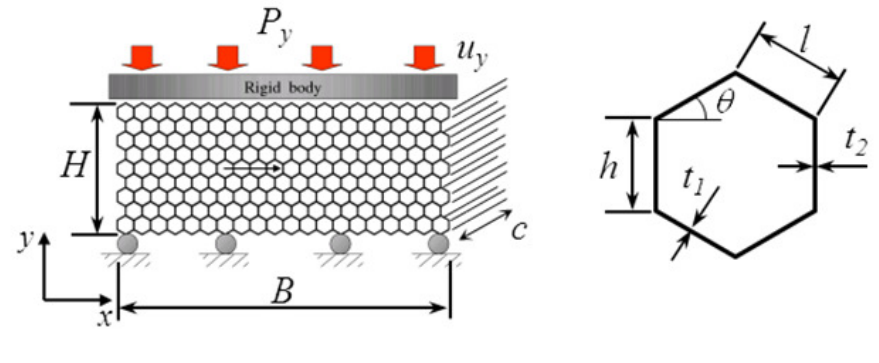
Figure 2. Analysis model of honeycomb structure with finite width and